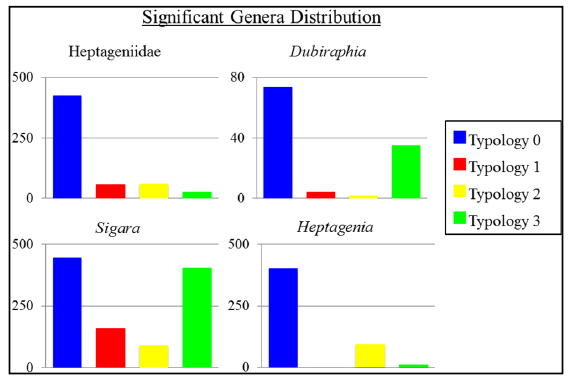
Figure 6. Bar charts depicting population distribution for the four genera found significant in Table 3, as related to the typologies.